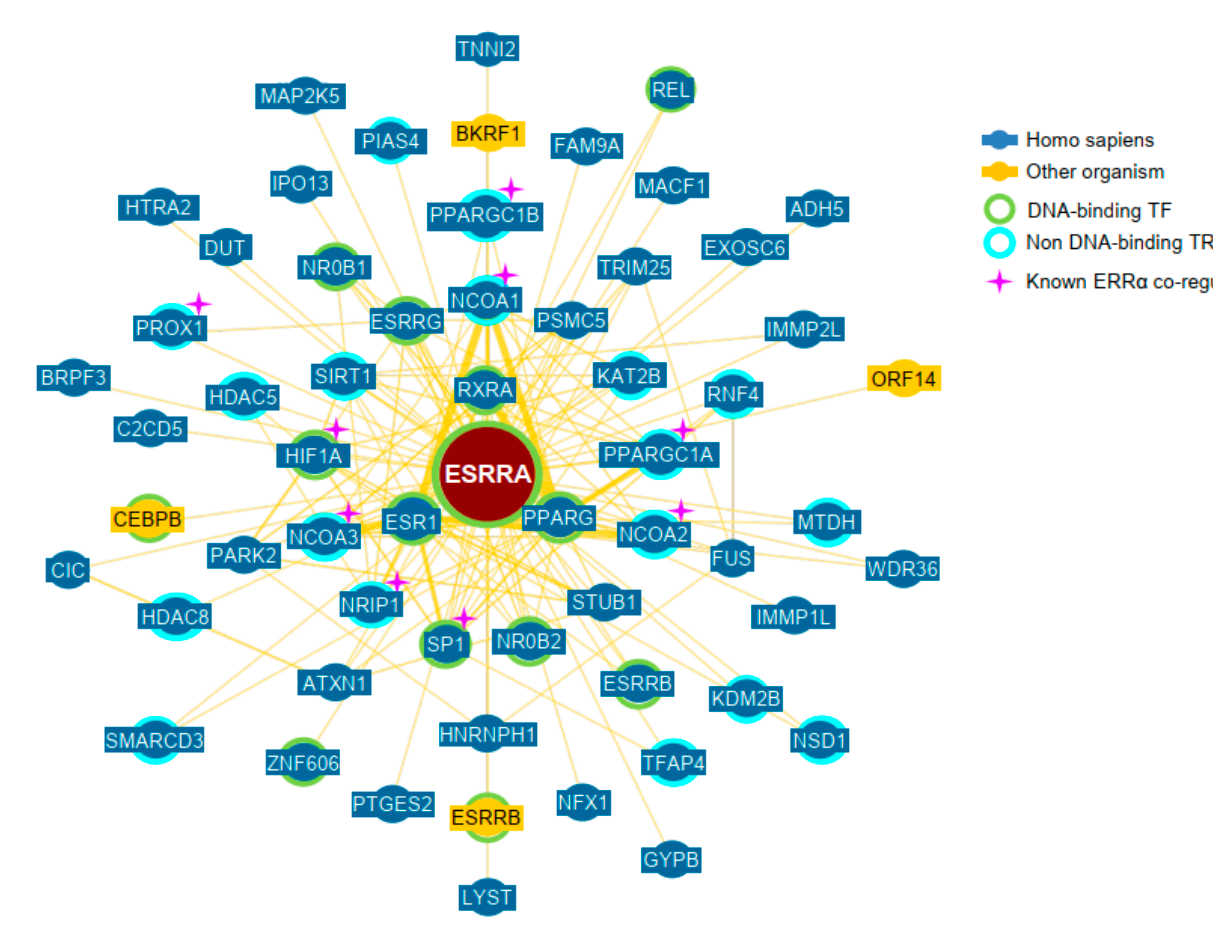
Figure 2. Network of ERR α interacting proteins. The network was obtained from the BioGRID database (https://thebiogrid.org/) on 17 December 2021. The yellow lines joining proteins indicate association with physical evidence. TF: transcription factor; TR: transcriptional regulator.